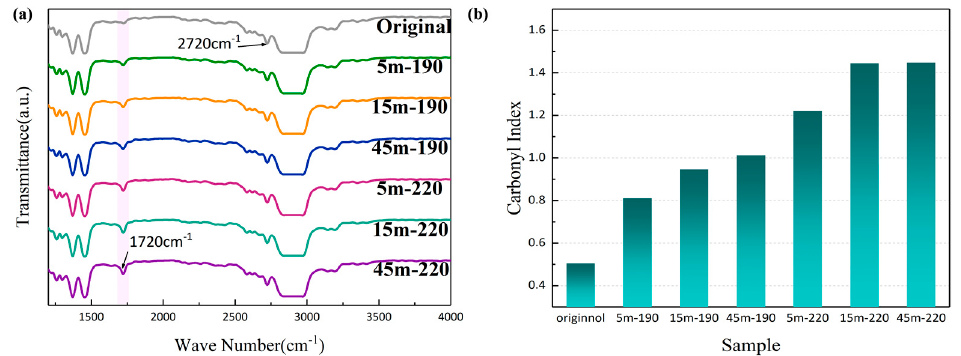
Figure 2. ( a ): Infrared spectra of samples under different degrees of shear, which were scanned from 500 cm − 1 to 4000 cm − 1 ; ( b ): Carbonyl index of samples.